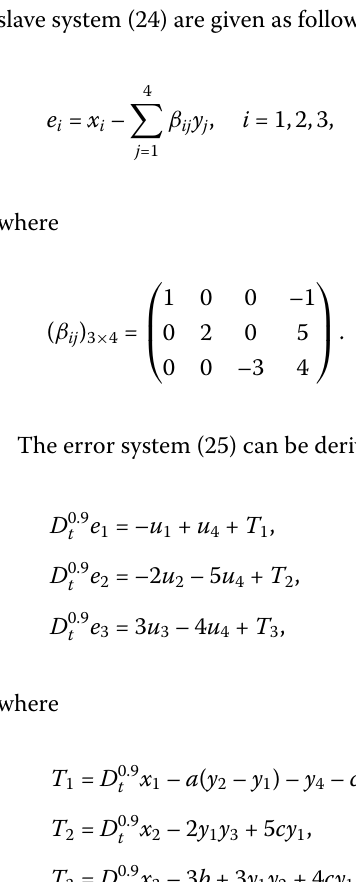
where U = ( u 1 , u 2 , u 3 , u 4 ) T is the vector controller. It is worth noting that the uncontrolled system (24) is a chaotic system without equilibrium points